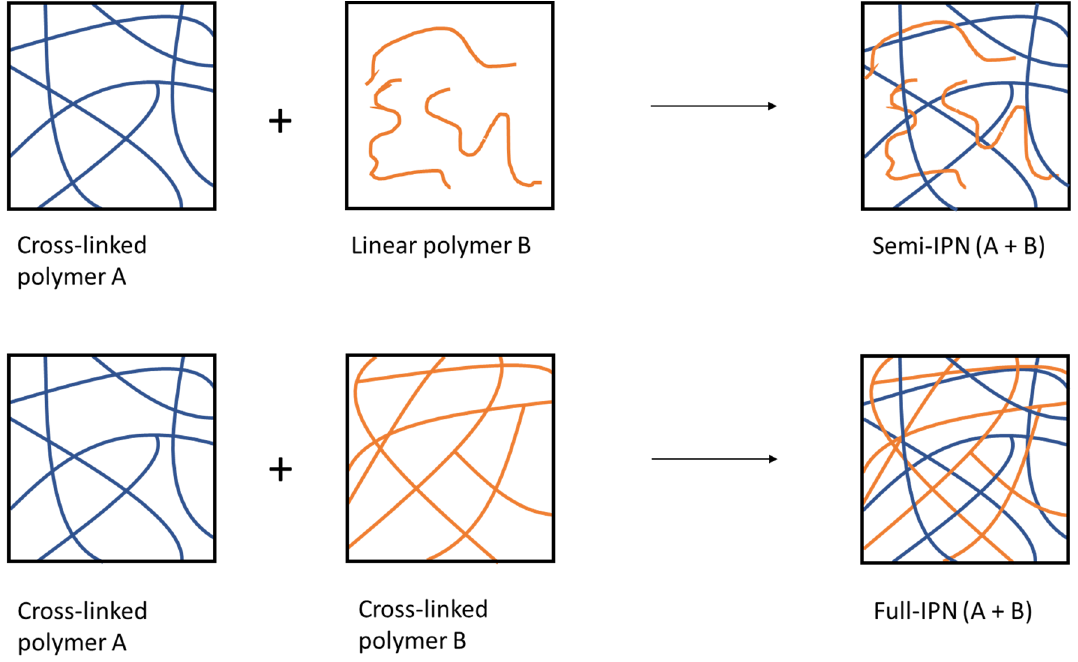
Figure 9. Schematic representation of semi-IPN and full-IPN .